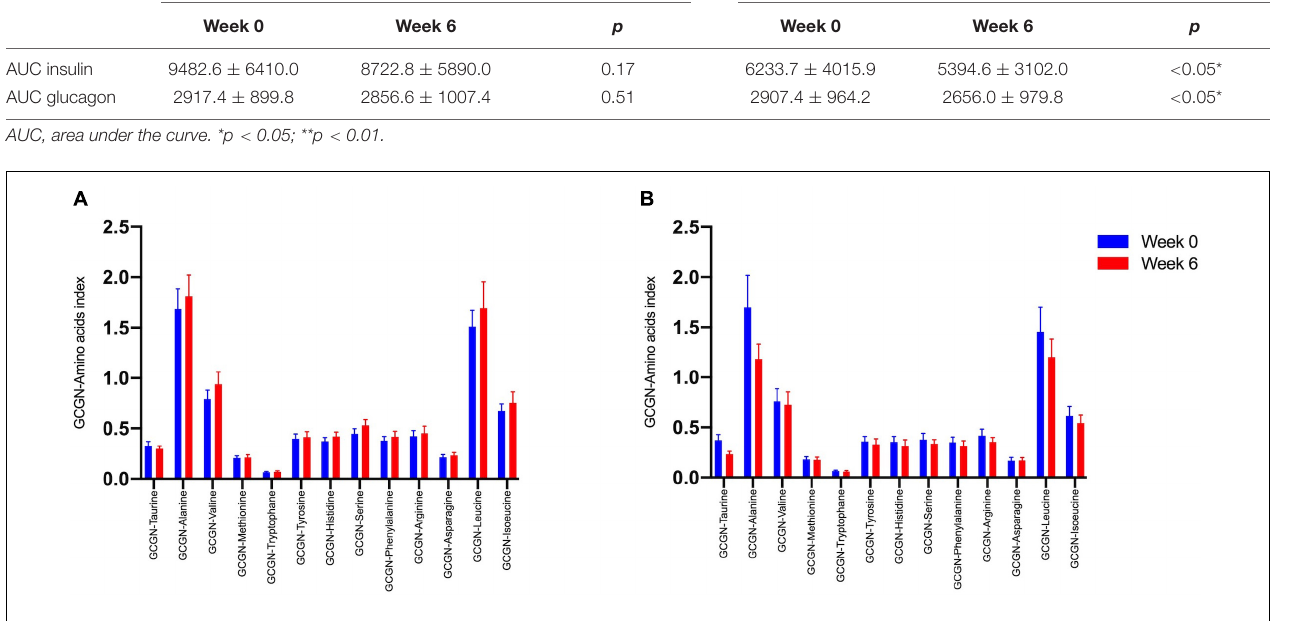
FIGURE 3 | Glucagon–alanine index between (A) lower IHL reduction groups; (B) higher IHL reduction group before (Week 0, blue) and after the intervention (Week 6, red).